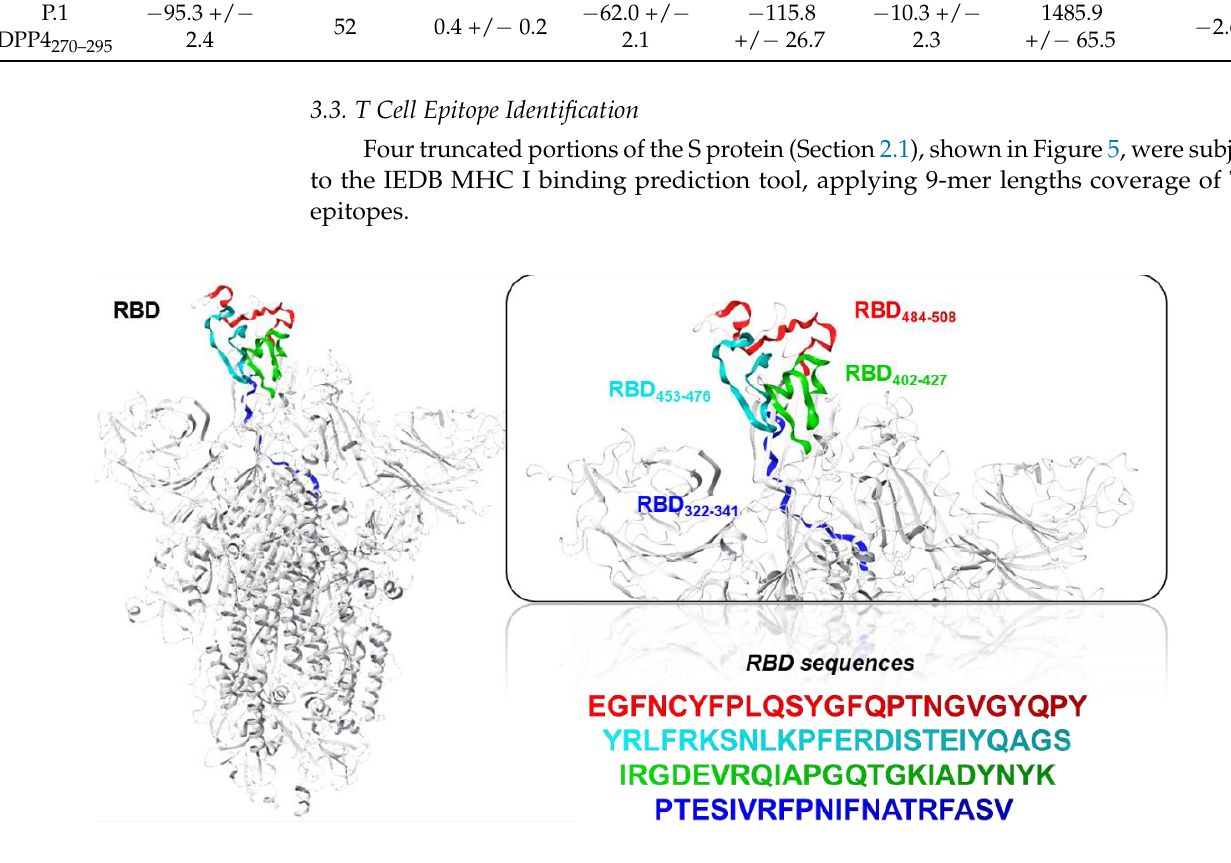
Figure 5. Illustration of the RBD S-protein main chain as a gray carbon cartoon. Right-hand images show zoomed-in context of the four sequences inducing RBD-specific antibodies, as proposed in the present study, which were coloured as red (RBD 484–508 ), cyan (RBD 453–476 ), green (RBD 402–427 ), or blue (RBD 322–341 ) main chain ribbons.